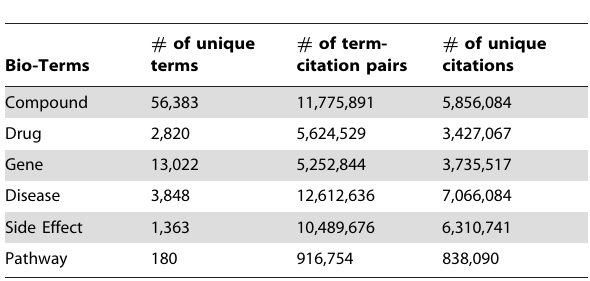
Table 1. Statistics of the bio-terms extraction.